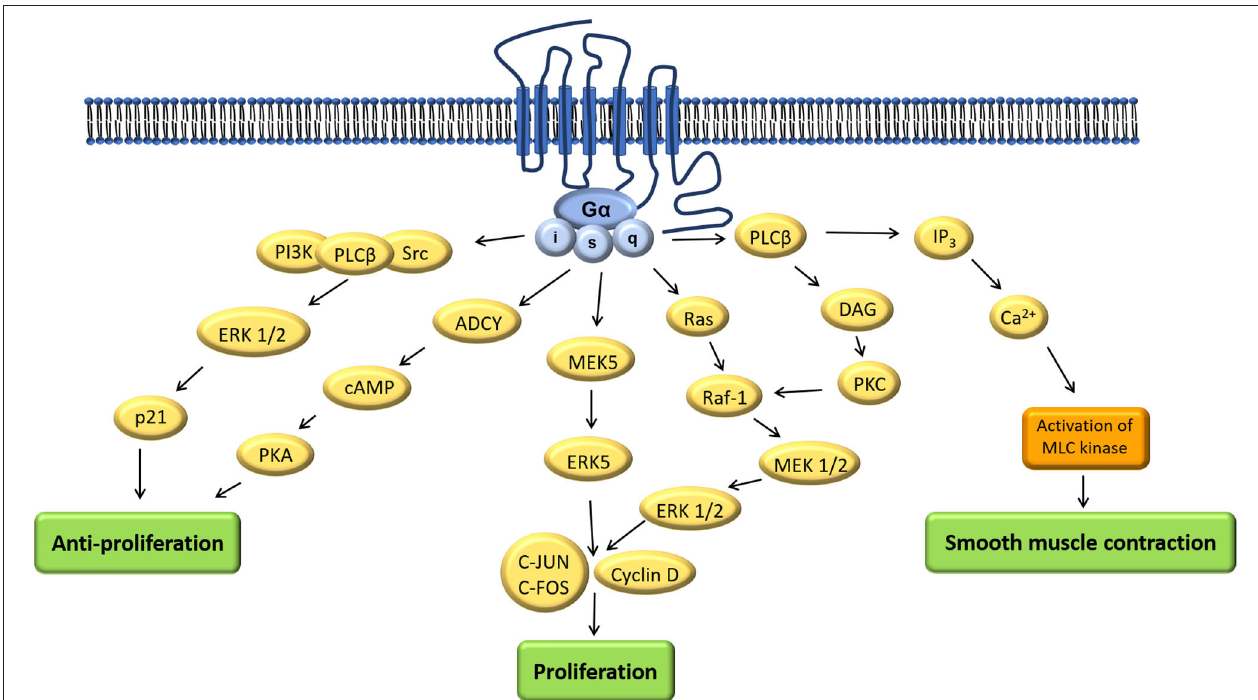
FIGURE 4 | Adapted: Mechanism of actions of oxytocin via different signaling pathways